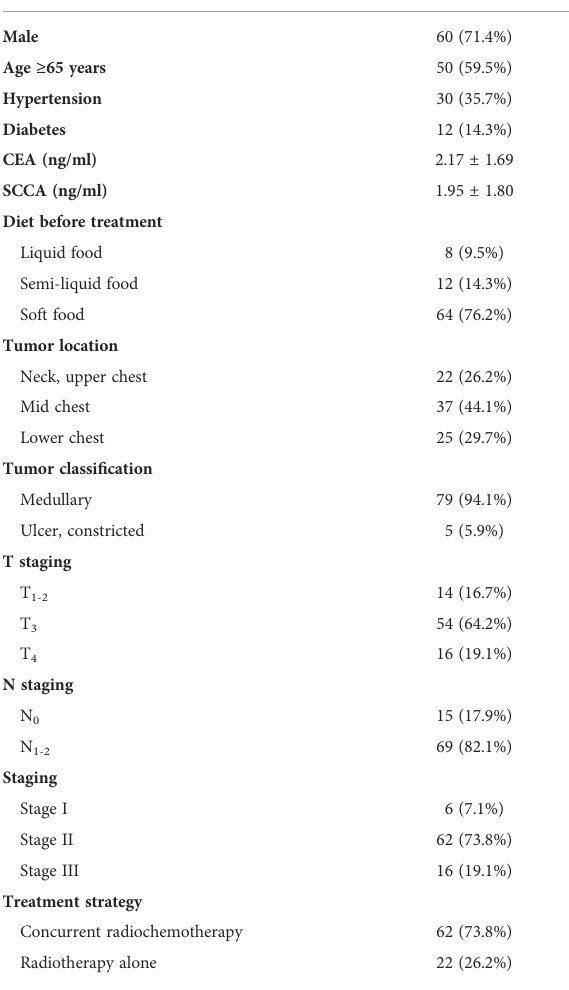
TABLE 1 Clinical data of study